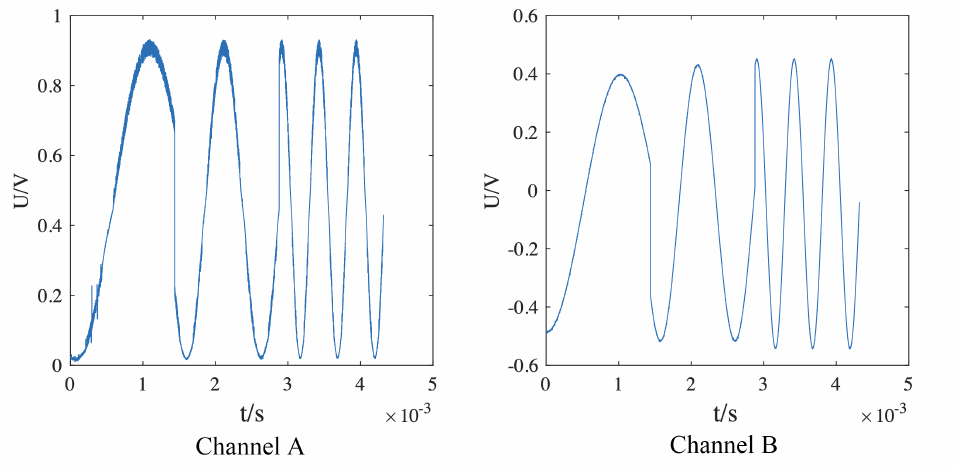
Figure 3. Time domain diagram of the acquisition